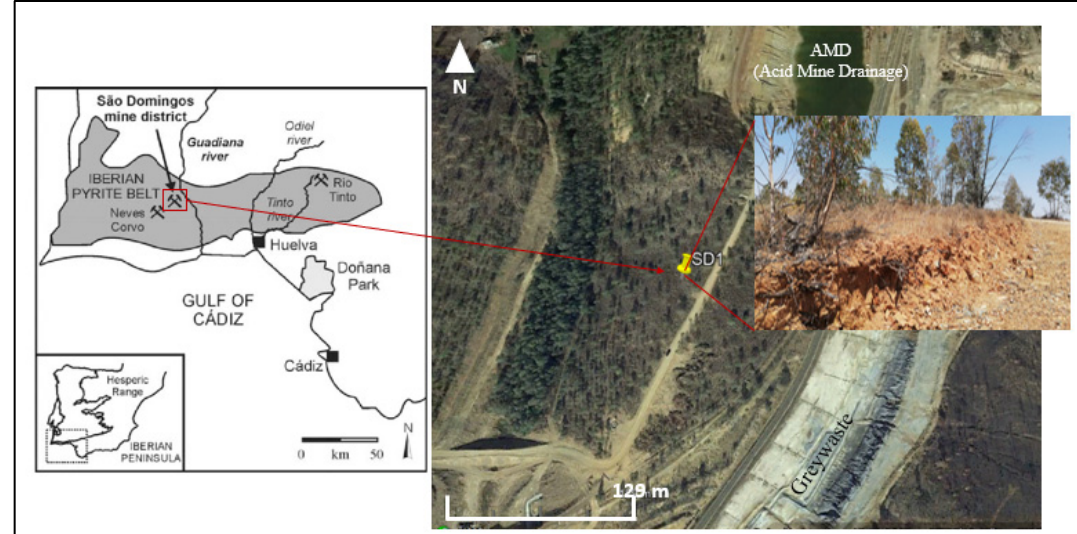
Figure 1. Location of São Domingos mine and location of the collected SD1 sample. Left figure is adapted from [17].